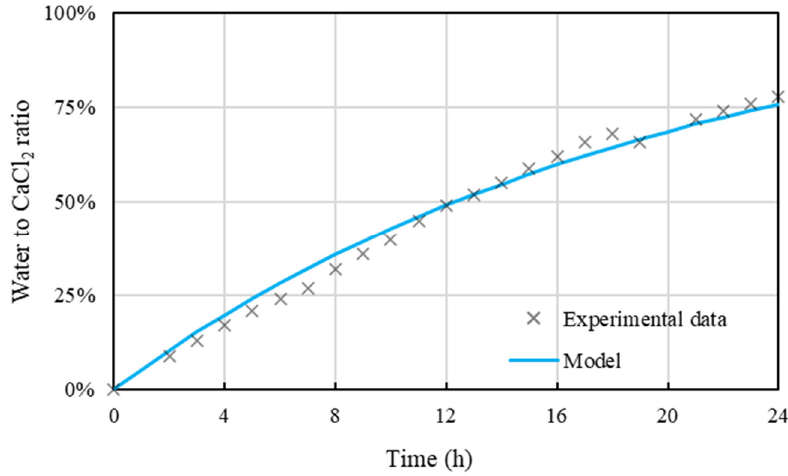
Figure 12. Logistic growth/decay model for CaCl 2 moisture